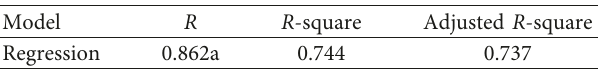
Table 2: R -squared analysis.